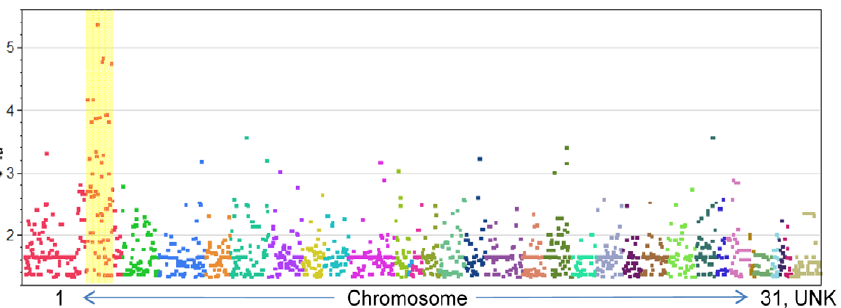
Figure 2. P-values ( , 0.05) for SNP association with Lavender Foal Syndrome. Individual chromosomes are represented with various colors in numerical order. The region with the most significant P-values (highlighted with a yellow bar) falls on the p arm of ECA1.